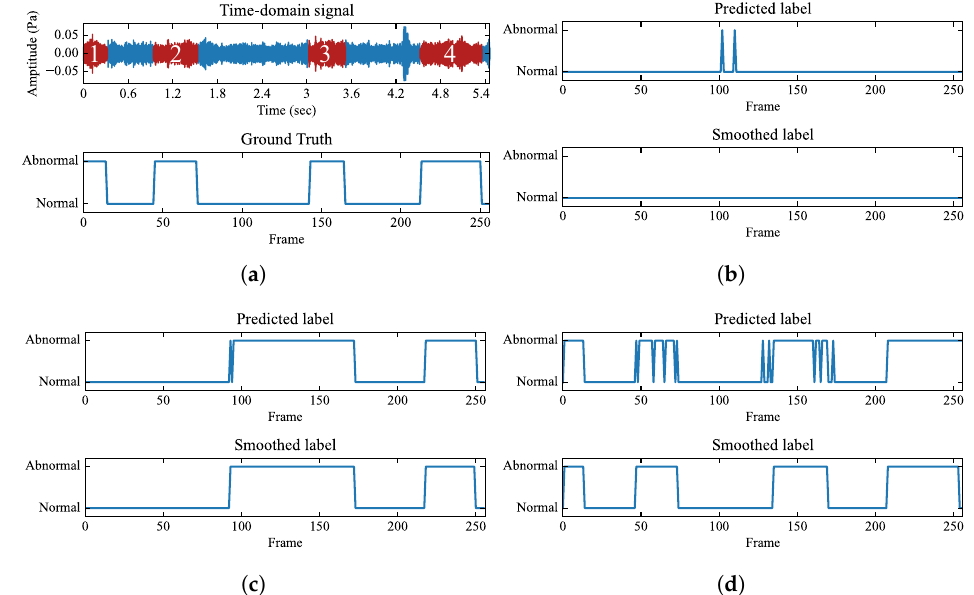
Figure 10. Frame-by-frame prediction and smoothing results for different methods: ( a ) FOD signal and true label, ( b ) CNN’s prediction results and smoothed results, ( c ) CRNN’s prediction results and smoothed results, ( d ) MS-CTCN’s prediction results and smoothed results.